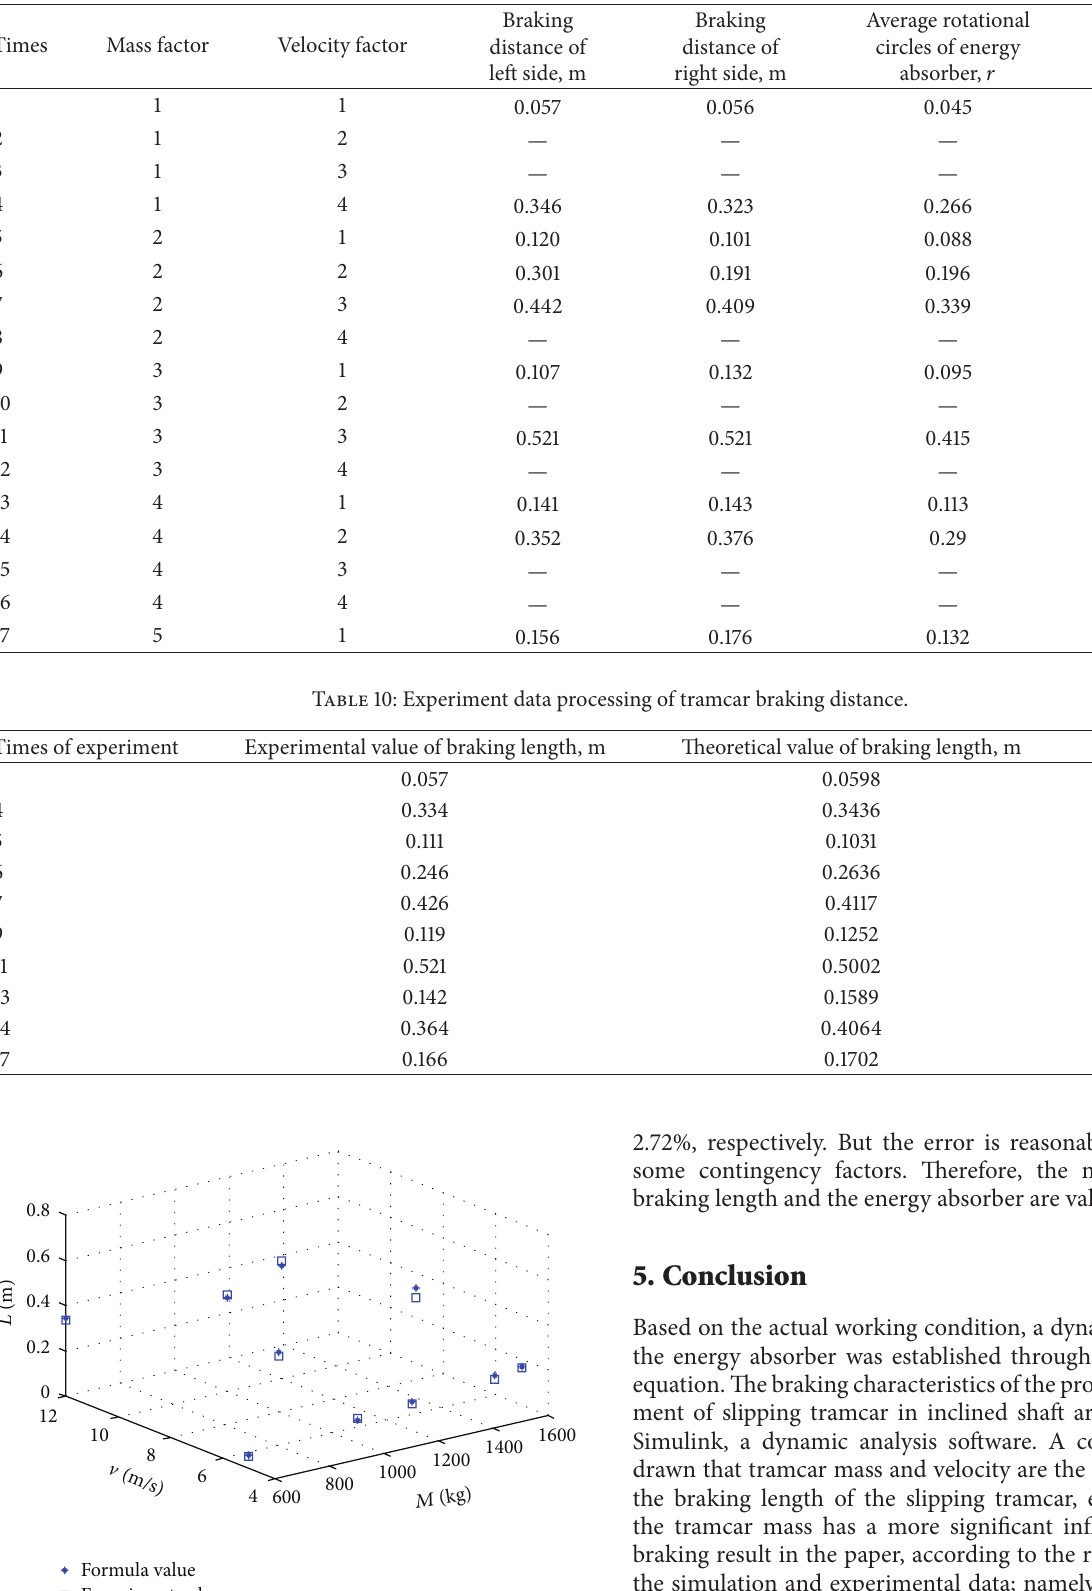
Table 9: Experiment data of tramcar braking distance.